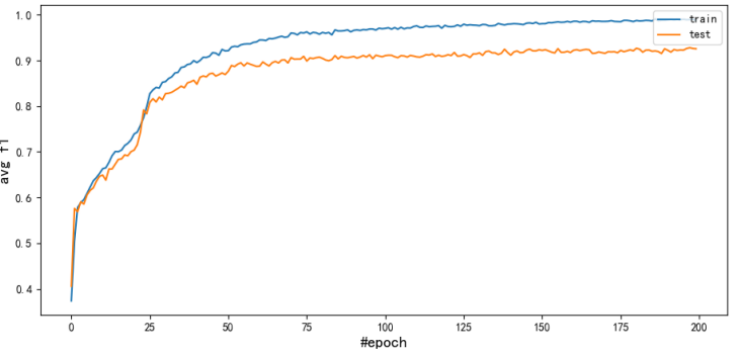
Figure 13. The change of average F1 value of each label category with training